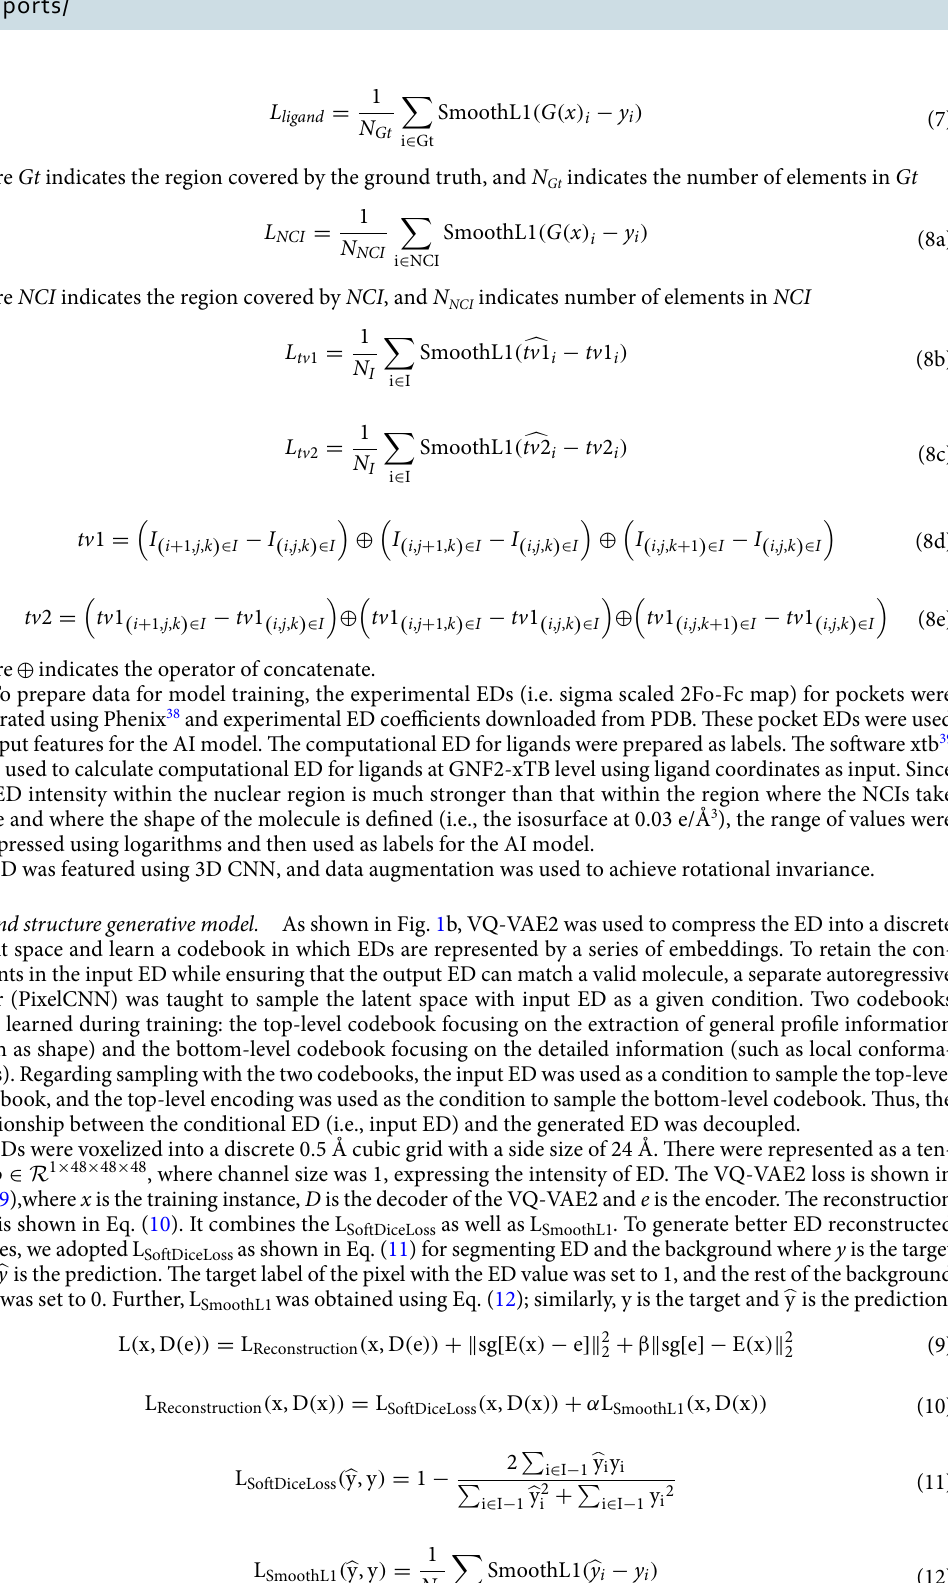
(11) L SoftDiceLoss